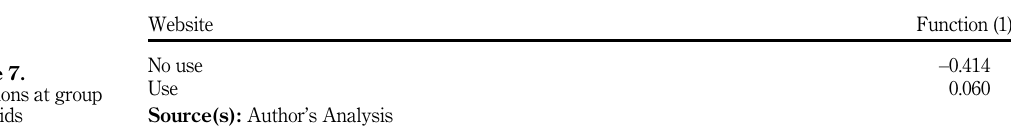
function coefficients (unstandardized)